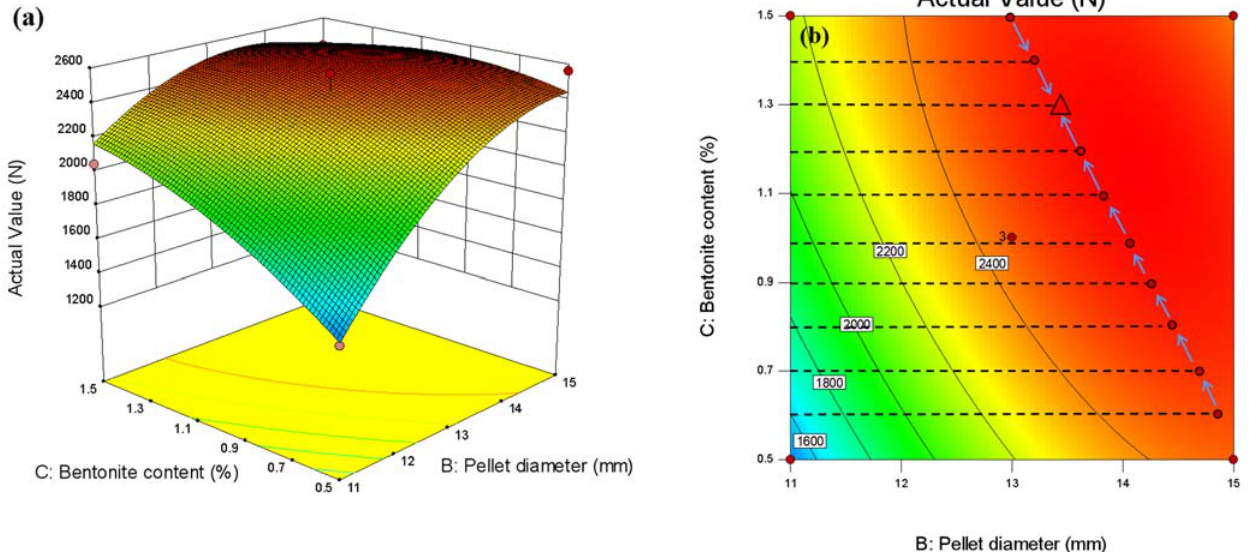
Figure 17. Response surface diagram between pellet diameter, bentonite content, and pellet compres- sive strength: ( a ) 3D response surface plot, ( b ) optimal parameter contour plot.